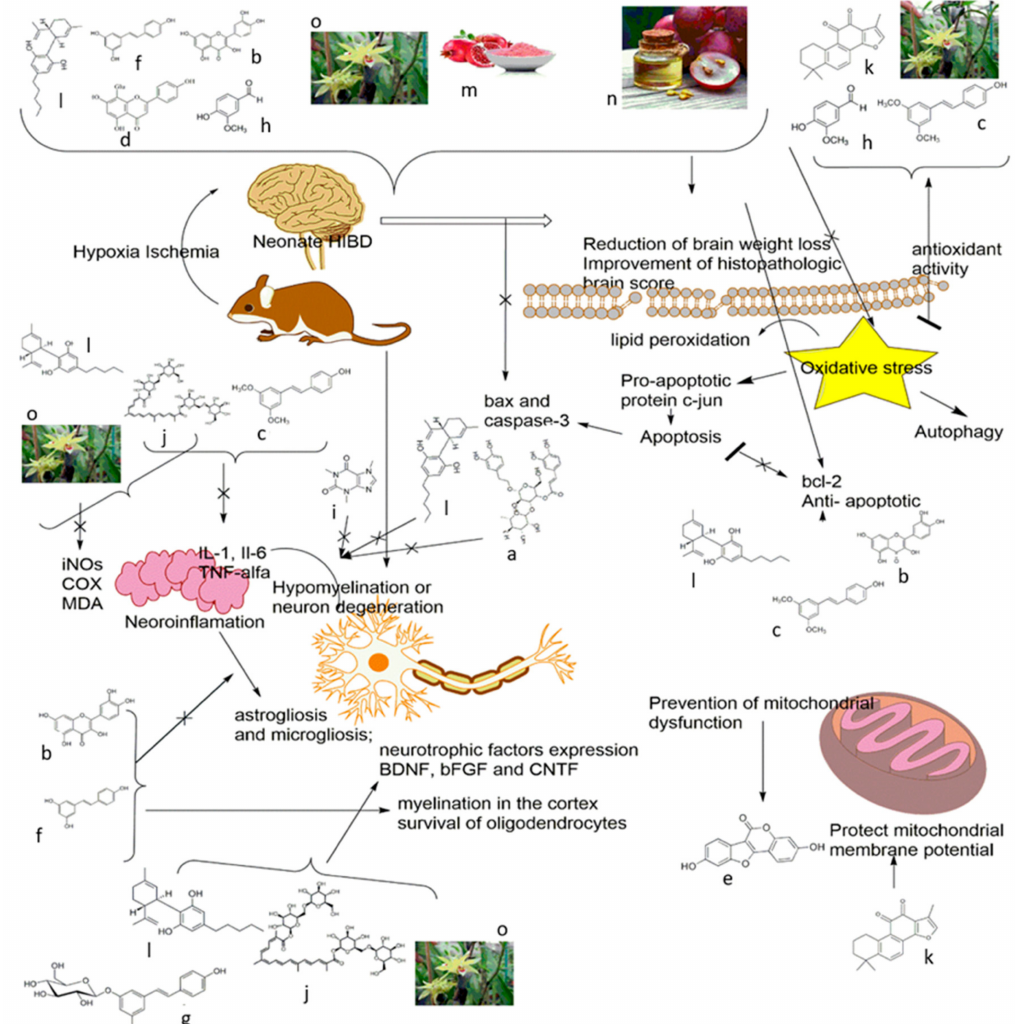
Figure 2. The excitatory, free radical toxicity, inflammation, and neuronal cell death mechanism of plant extracts/plant- derived compounds in animal models of neonatal hypoxic-ischemic brain injury. ( a ) Verbascoside, ( b ) Quercetin, ( c ) Pterostilbene, ( d ) Vitexin, ( e ) Coumestrol, ( f ) Resveratrol, ( g ) Polydatin, ( h ) Vanillin, ( i ) Caffeine, ( j ) Crocin, ( k ) Tanshinone IIA, ( l ) Cannabidiol, ( m ) Pomegranate juice and Pomegranate polyphenol extract, ( n ) Grape seed extract and Grape seed proanthocyanidin extract, ( o ) Dendribium